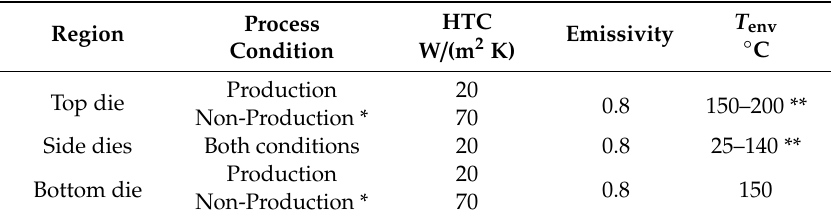
Table 5. Parameters for the environmental heat transfer.